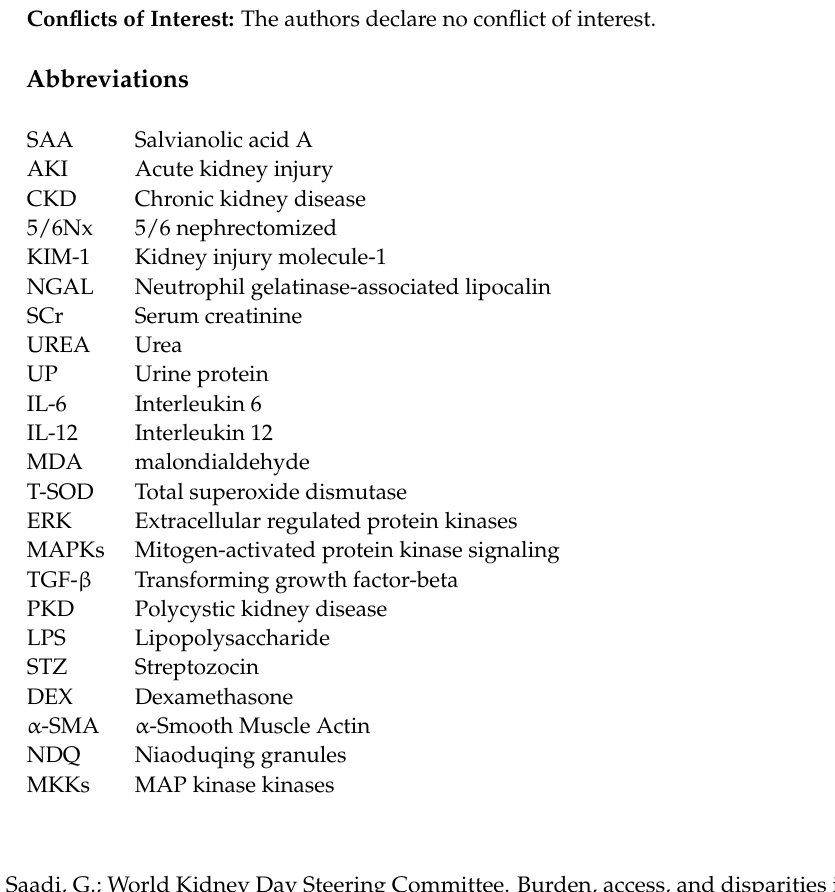
Table S2: The target genes of CKD; Table S3: target genes of CKD and